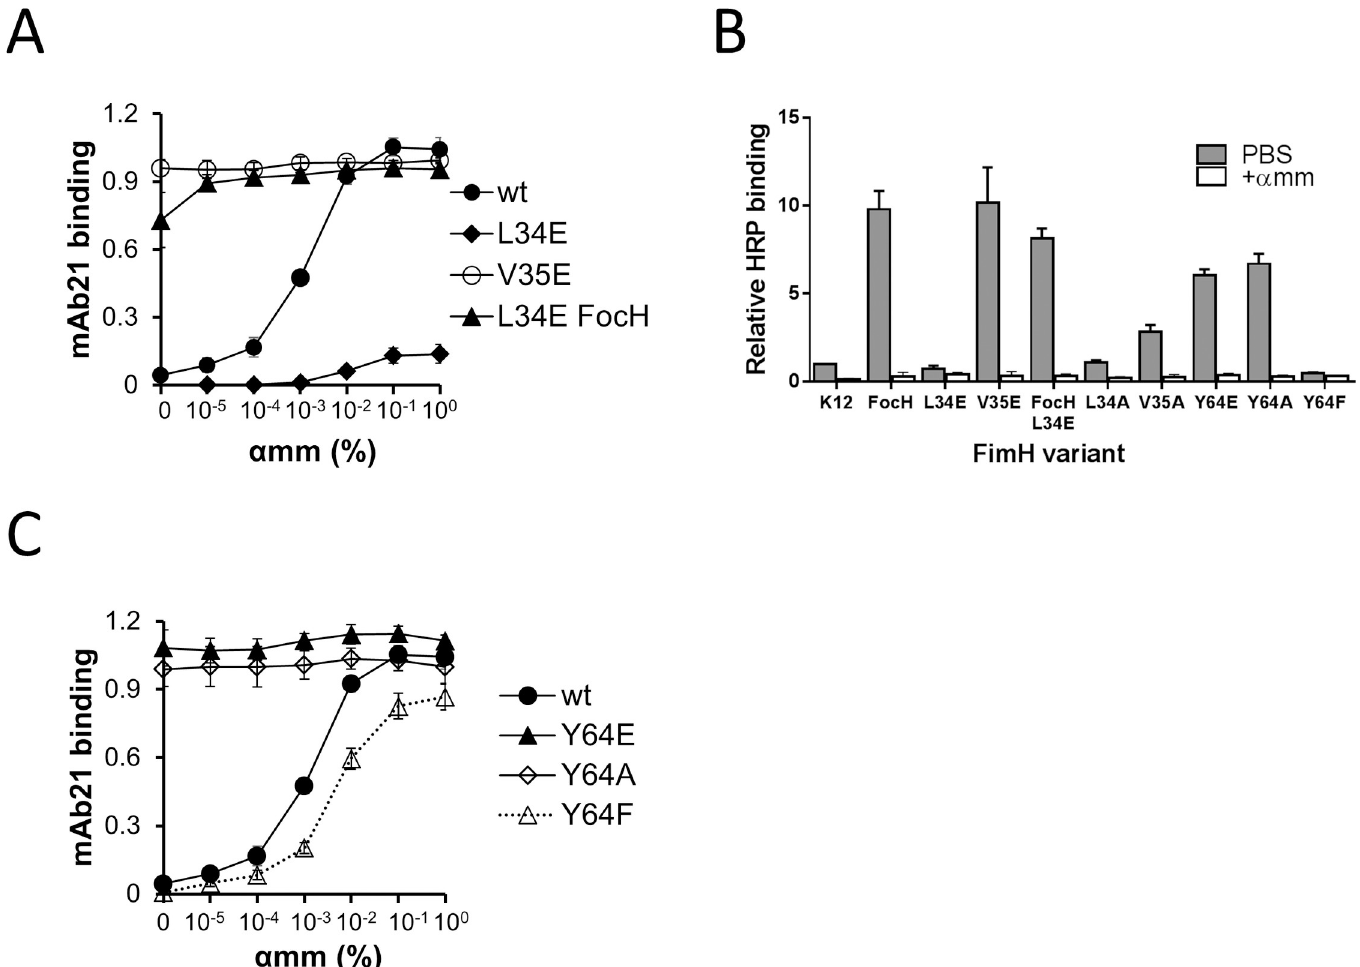
Fig 6. Effect of mutation of the switch residues on FimH conformational change and function. (A and C) Presence of the HAS conformation of FimH wt and mutants was detected by the HAS-specific mAb21 antibody in ELISA assays. Plate-immobilized fimbriae carrying wild type and mutated variants of FimH were probed with mAb21 in the absence and presence of serially diluted α mm. The data are absorbance values at 650 nm. (B) Relative binding of the mannose-rich glycoprotein (horseradish peroxide, HRP) to the plate-immobilized fimbriae in the absence and presence of 1% α mm. Data (A-C) are mean ± SEM, n = at least 2 independent